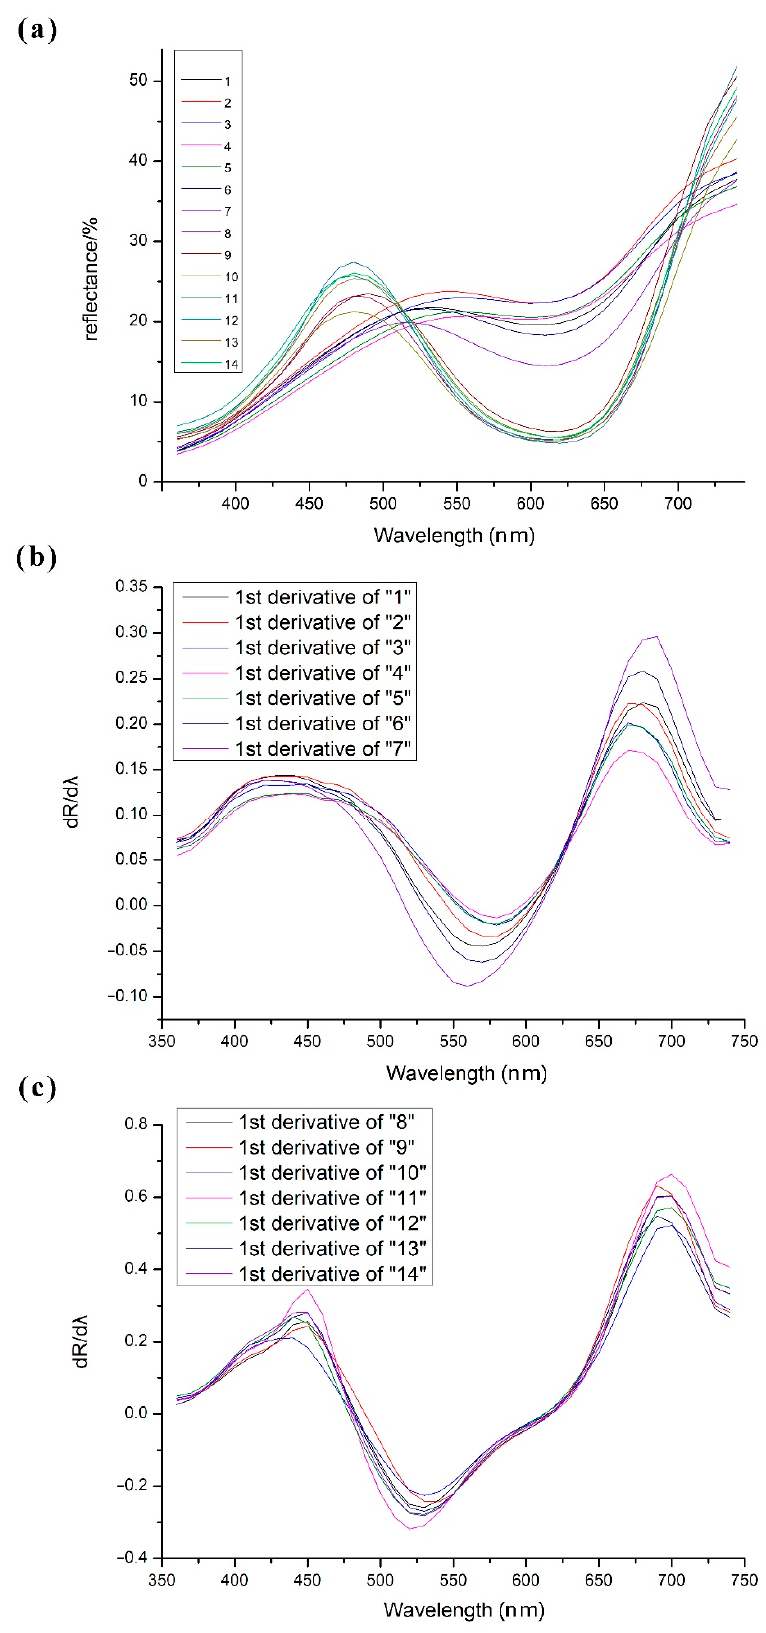
Figure 6. Reflectance spectra of the curtain relics: ( a ) raw spectra of no. 1–14; first derivative curves of ( b ) no. 1–7 and ( c ) no. 8–14 (no. represents the marked numbers).